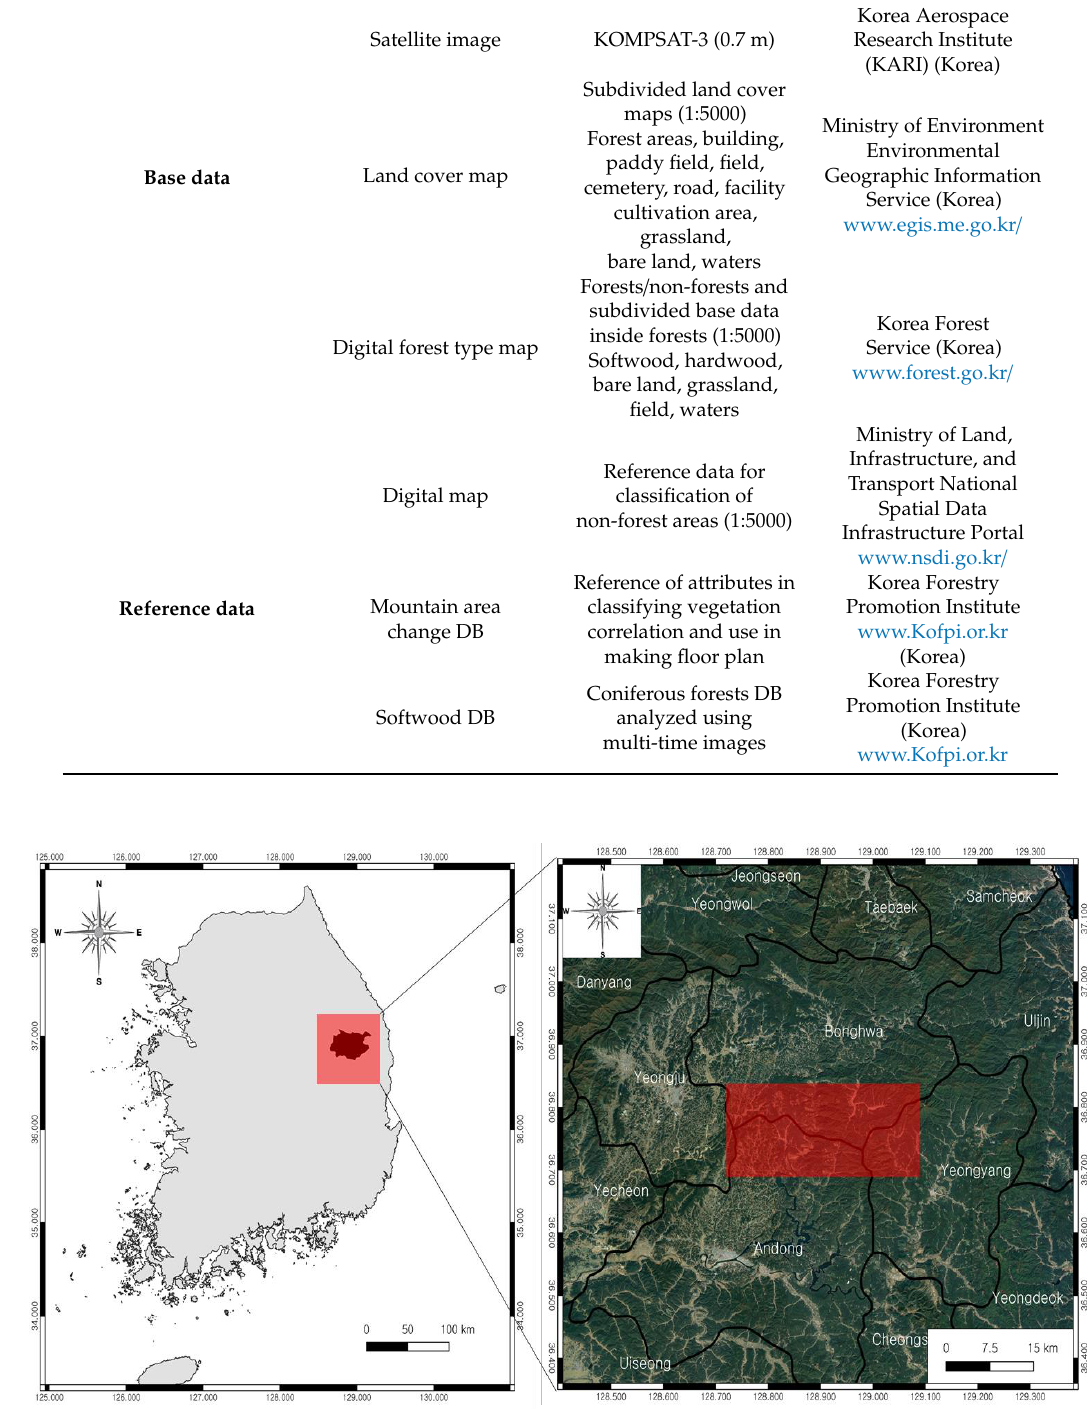
Table 1. Base data and reference data in this study.